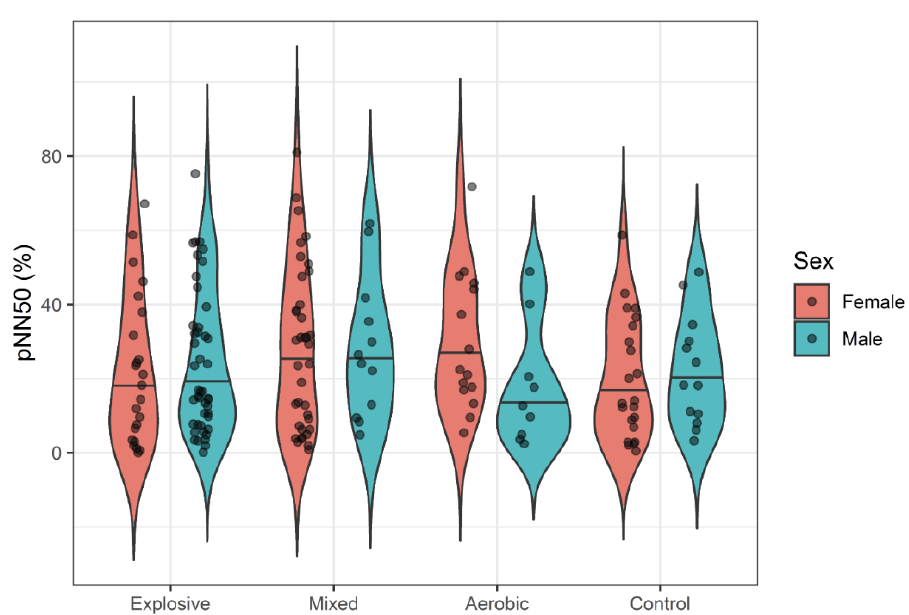
Figure 4. pNN50 by Athlete Type.